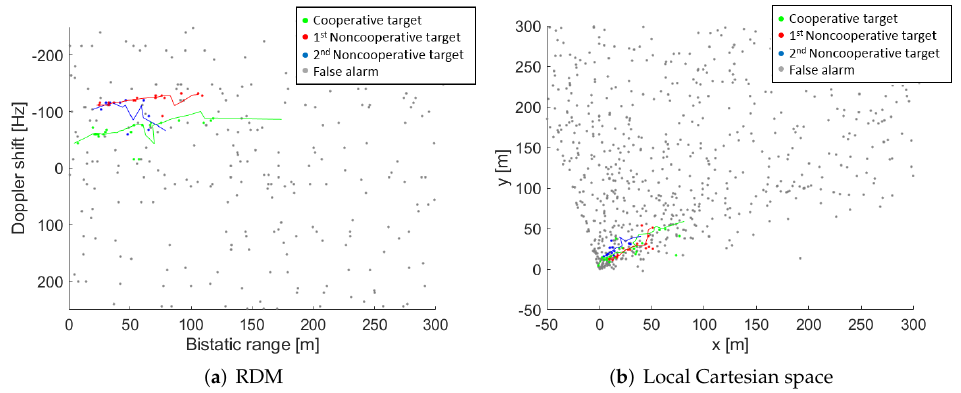
Figure 12. Real radar data results: Cumulative detection output in measurement and tracking domain. ( a ) RDM. ( b ) Local Cartesian space.